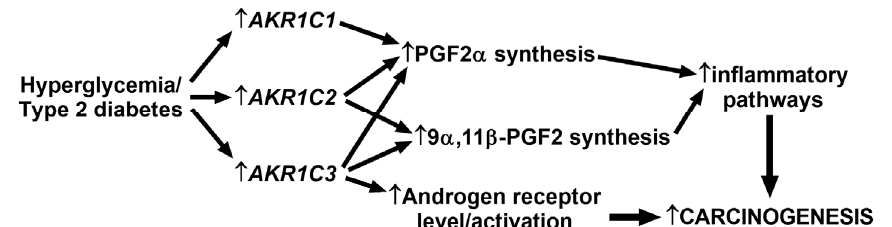
Figure 5. Proposed carcinogenic activity of the increased AKR1C transcript levels in prostate samples of patients with type 2 diabetes. AKR1C1, C2, and C3 enzymes are responsible for prostaglandin 2 α (PGF2 α ) and 9 α ,11 β -prostaglandin 2 (9 α ,11 β -PGF2) synthesis. These prostaglandins can activate the NF κ B pathways and inflammatory processes that drive carcinogenesis. Furthermore, AKR1C3 is involved in the synthesis of androgen receptor ligands (testosterone and dihydrotestosterone) and may also induce the transcript of androgen receptors. The elevated androgen receptor signaling has been described to induce carcinogenic processes in PCa.